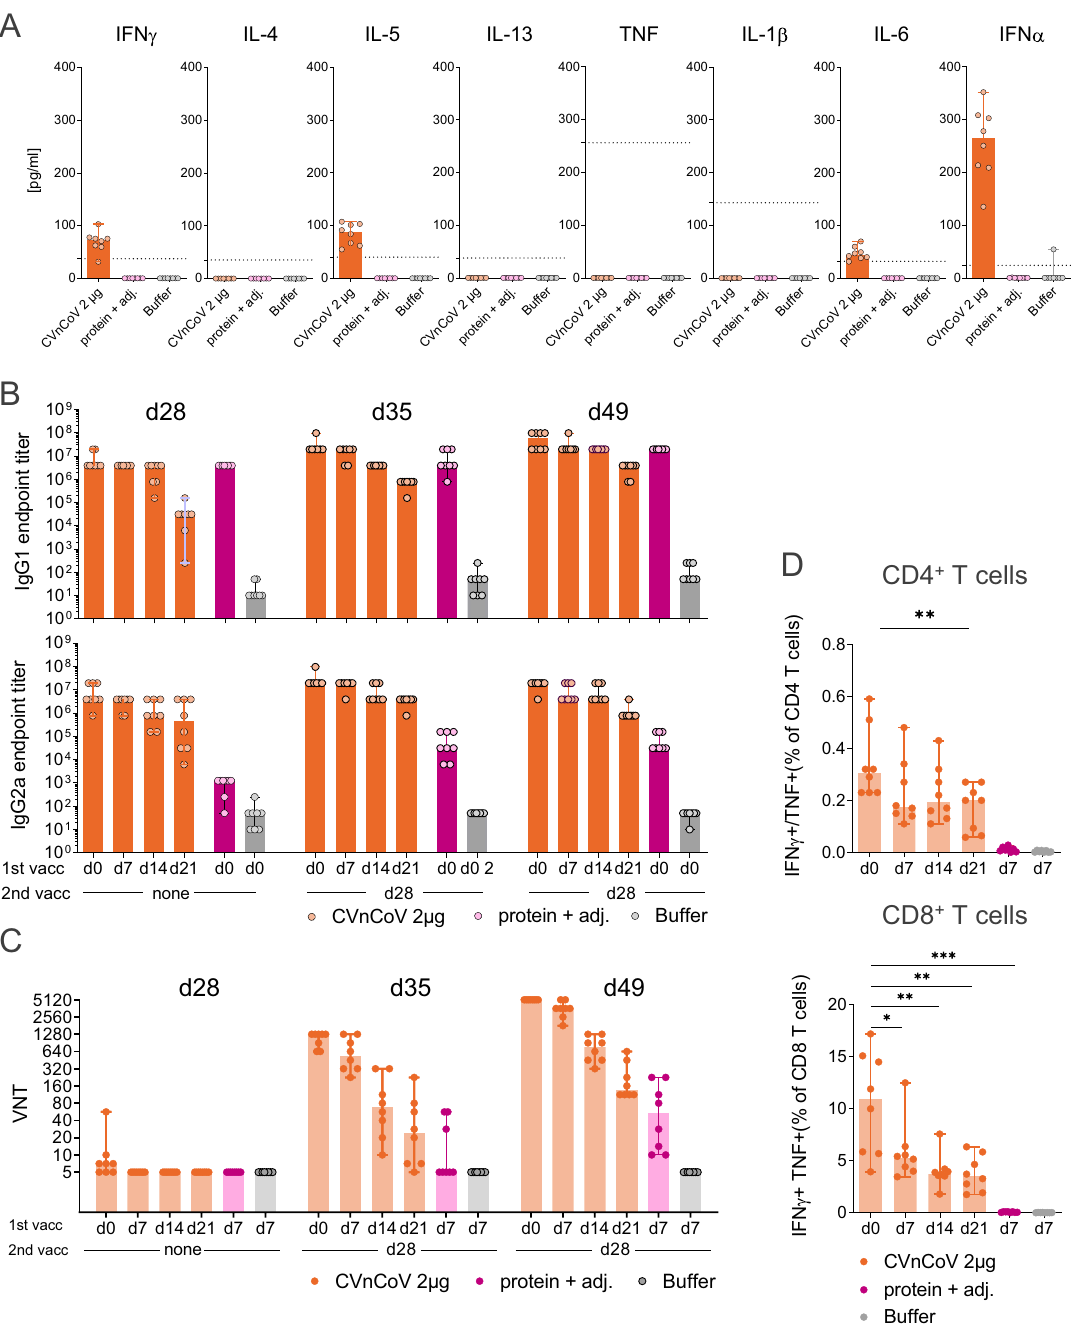
Fig. 2 CVnCoV elicits high levels of humoral and cellular immune responses. Female Balb/c mice ( n = 8/group) were vaccinated IM on day 0, day 7, day 14 or day 21 with 2 µg of CVnCoV. All animals received a second immunisation on day 28 and 1.5 µg of Alum-adjuvanted SARS- CoV-2 S ectodomain (S ECD ) protein and 0.9% NaCl (buffer) administered on day 0 and day 28 served as positive and negative control, respectively. A Cytokine induction in sera of vaccinated mice was assessed 14 h post injection. Dotted lines represent the lower limit of quanti fi cation. B S ECD protein-speci fi c binding antibodies, displayed as endpoint titres for IgG1 and IgG2a and C CPE-based virus-neutralising titres in serum upon one (day 28) or two vaccinations (day 35 and day 49). D Multifunctional IFN- γ /TNF-positive CD4 + T and CD8 + T cells analysed in splenocytes isolated on day 49. Cells were stimulated with a speci fi c SARS-CoV-2 spike protein peptide library (15mers 11 overlapping) for 24 h followed by intracellular cytokines staining and detection by fl ow cytometry. Each dot represents an individual animal, bars depict the median. Statistical analysis was performed using Mann – Whitney